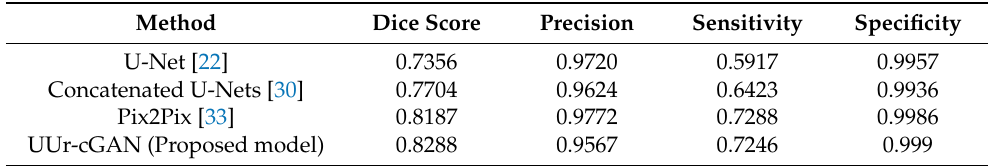
Table 4. Average k- Fold metrics for different methods and proposed model, for the multiphoton microscopy dataset